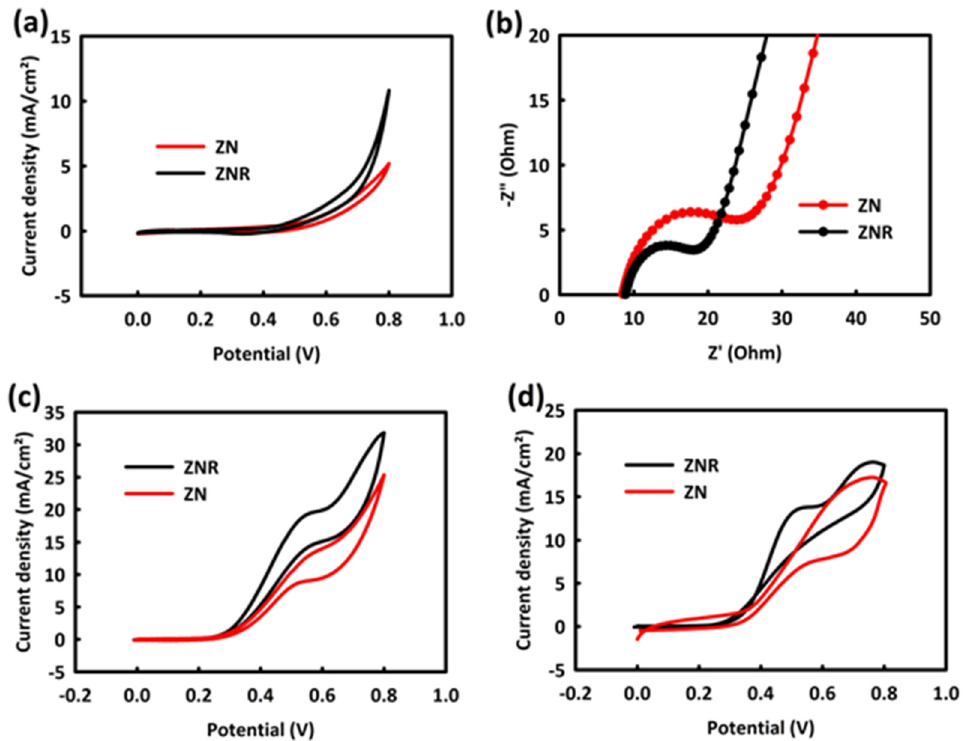
Figure 3. CV curves ( a ) and EIS plots ( b ) of ZrO 2 /NiO and ZrO 2 /NiO/rGO in 0.5 M KOH. CV curves of ZrO 2 /NiO and ZrO 2 /NiO/rGO in 0.5 M KOH/0.1 M methanol ( c ) and 0.5 M KOH/0.1 M ethanol ( d ).